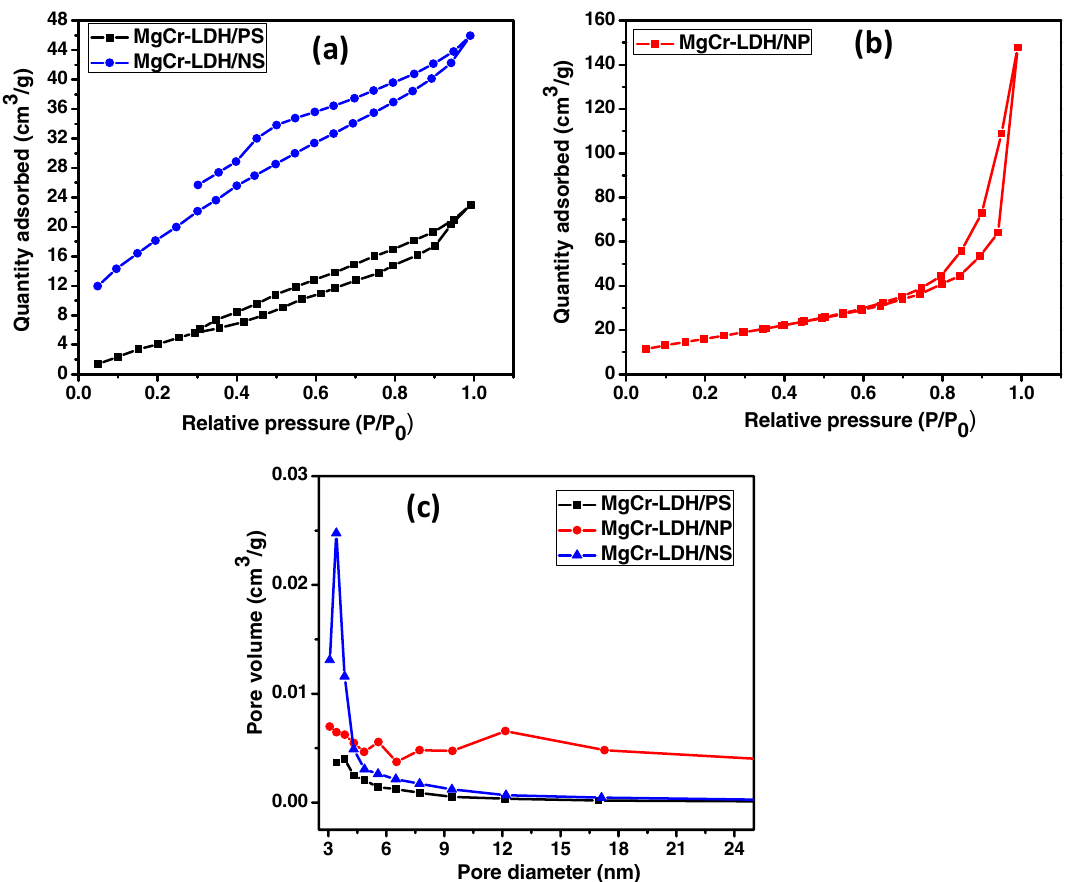
Figure 4. ( a ) N 2 sorption isotherm; ( b ) pore size distribution of mesoporous MgCr-LDH/PS, MgCr-LDH/NS and